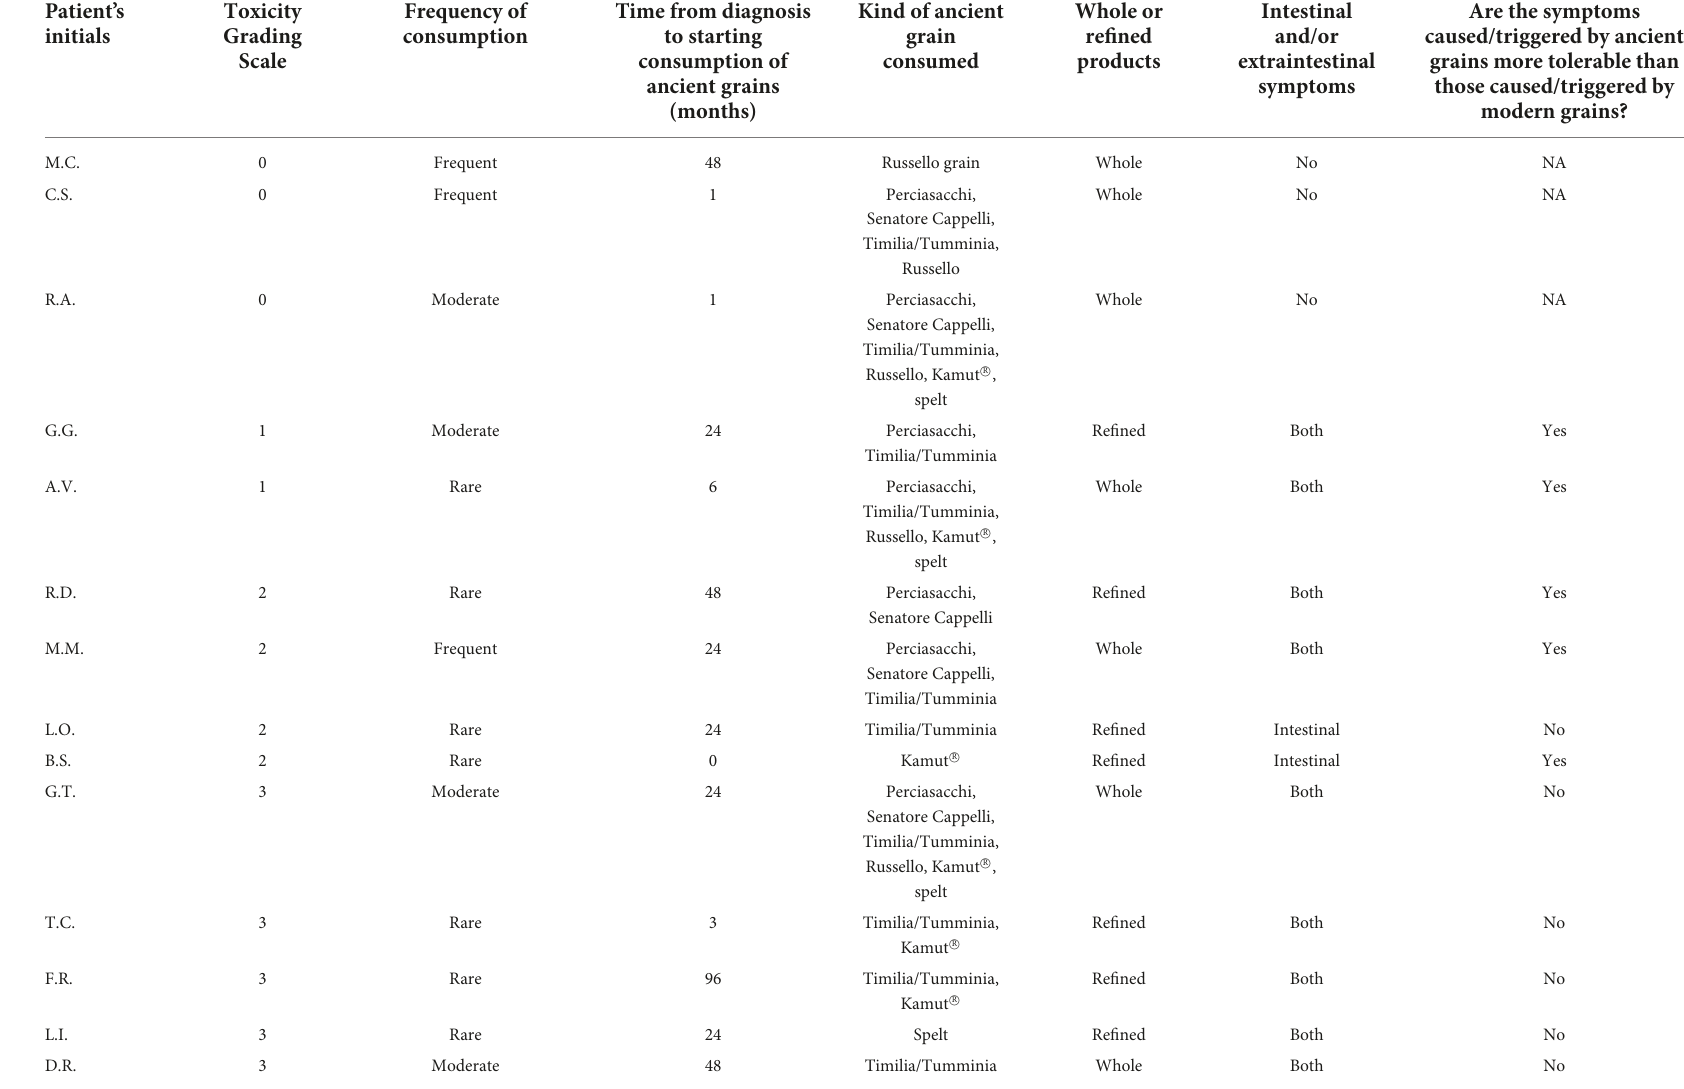
TABLE 3 Tolerability and consumption of ancient grains after NCWS diagnosis in 14 patients with strict adherence to modern WFD, according to toxicity grading scale